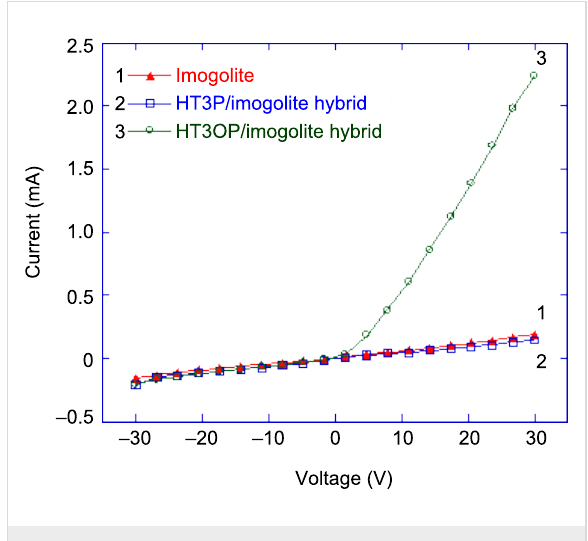
Figure 19: I – V curves of imogolite, HT3P/imogolite, and HT3OP/ imogolite hybrid. Reprinted with permission from W. O. Yah et al., Bull. Chem. Soc. Jpn. 2011, 84, 893–902 [60]. © 2011, The Chemical Society of